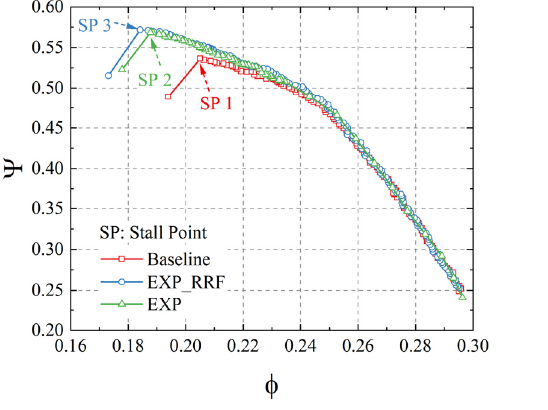
( b ) Figure 12. The repeated experiment results of TA36 under baseline condition: ( a ) pressure rise characteristics; and ( b ) efficiency characteristics.